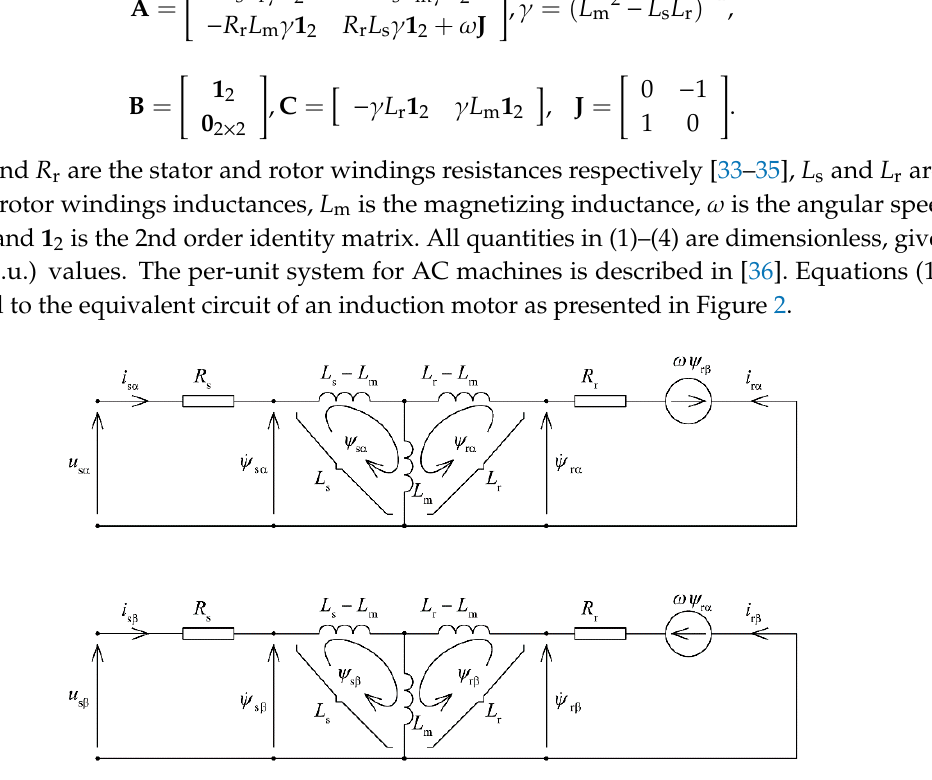
Figure 2. The equivalent circuit of an induction motor in stationary Cartesian coordinate system α - β .